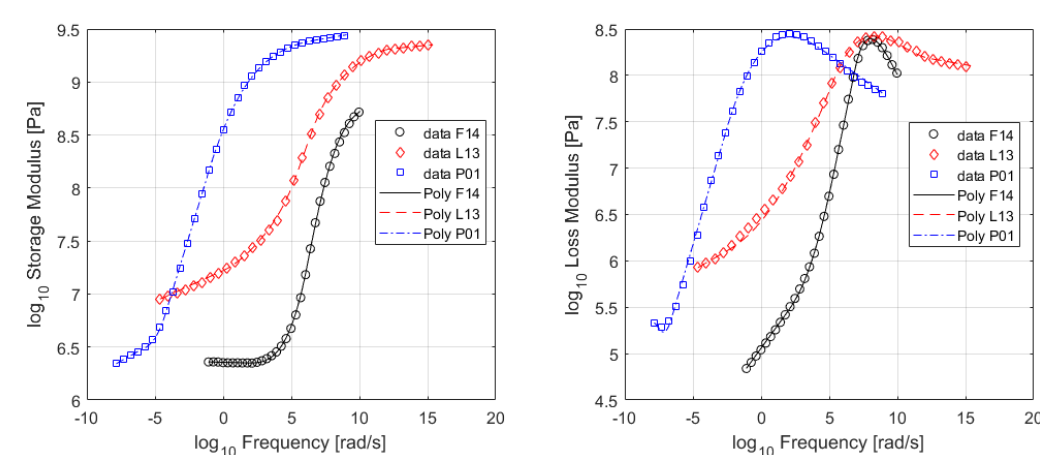
Figure 5. Storage ( left chart ) and loss ( right chart ) moduli for three rubber compounds. Experimental data (markers) vs. polynomial model (lines).